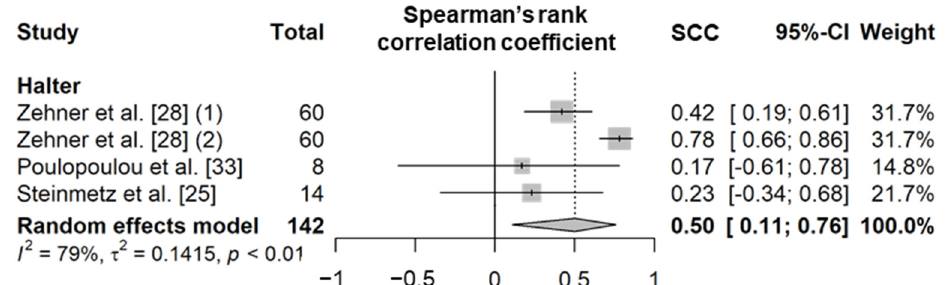
Figure 5. Forest plot of the Spearman’s correlation coefficient of drinking time between wearable sensors and visual observation. Numbers in parentheses indicate individual studies applying different evaluation conditions within the same article. ‘Total’ means the sample size of each study and ‘Weight’ means the weight for the mean based on the sample size.